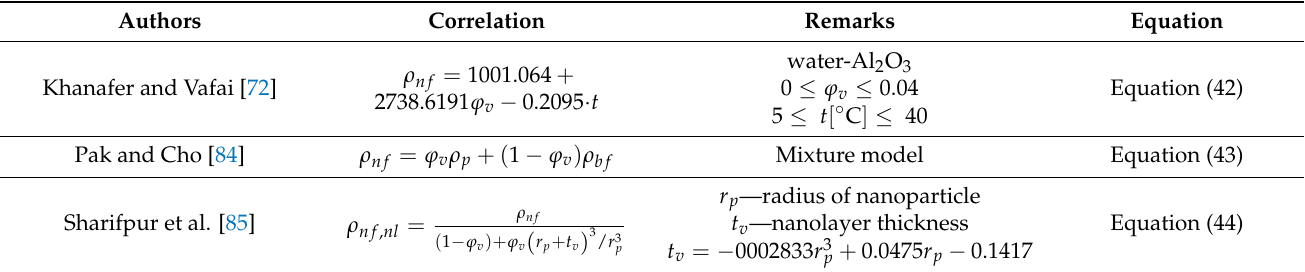
Figure 6. Thermal conductivity of water-Al 2 O 3 nanofluids. Table 8. Correlations for density of nanofluids.